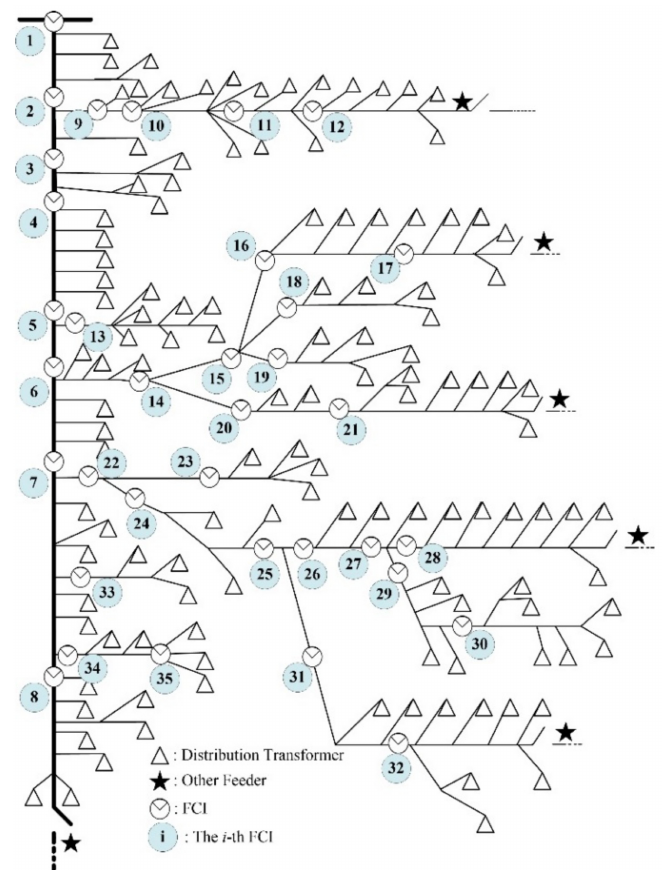
Figure 10. One-line diagram of an actual distribution system.